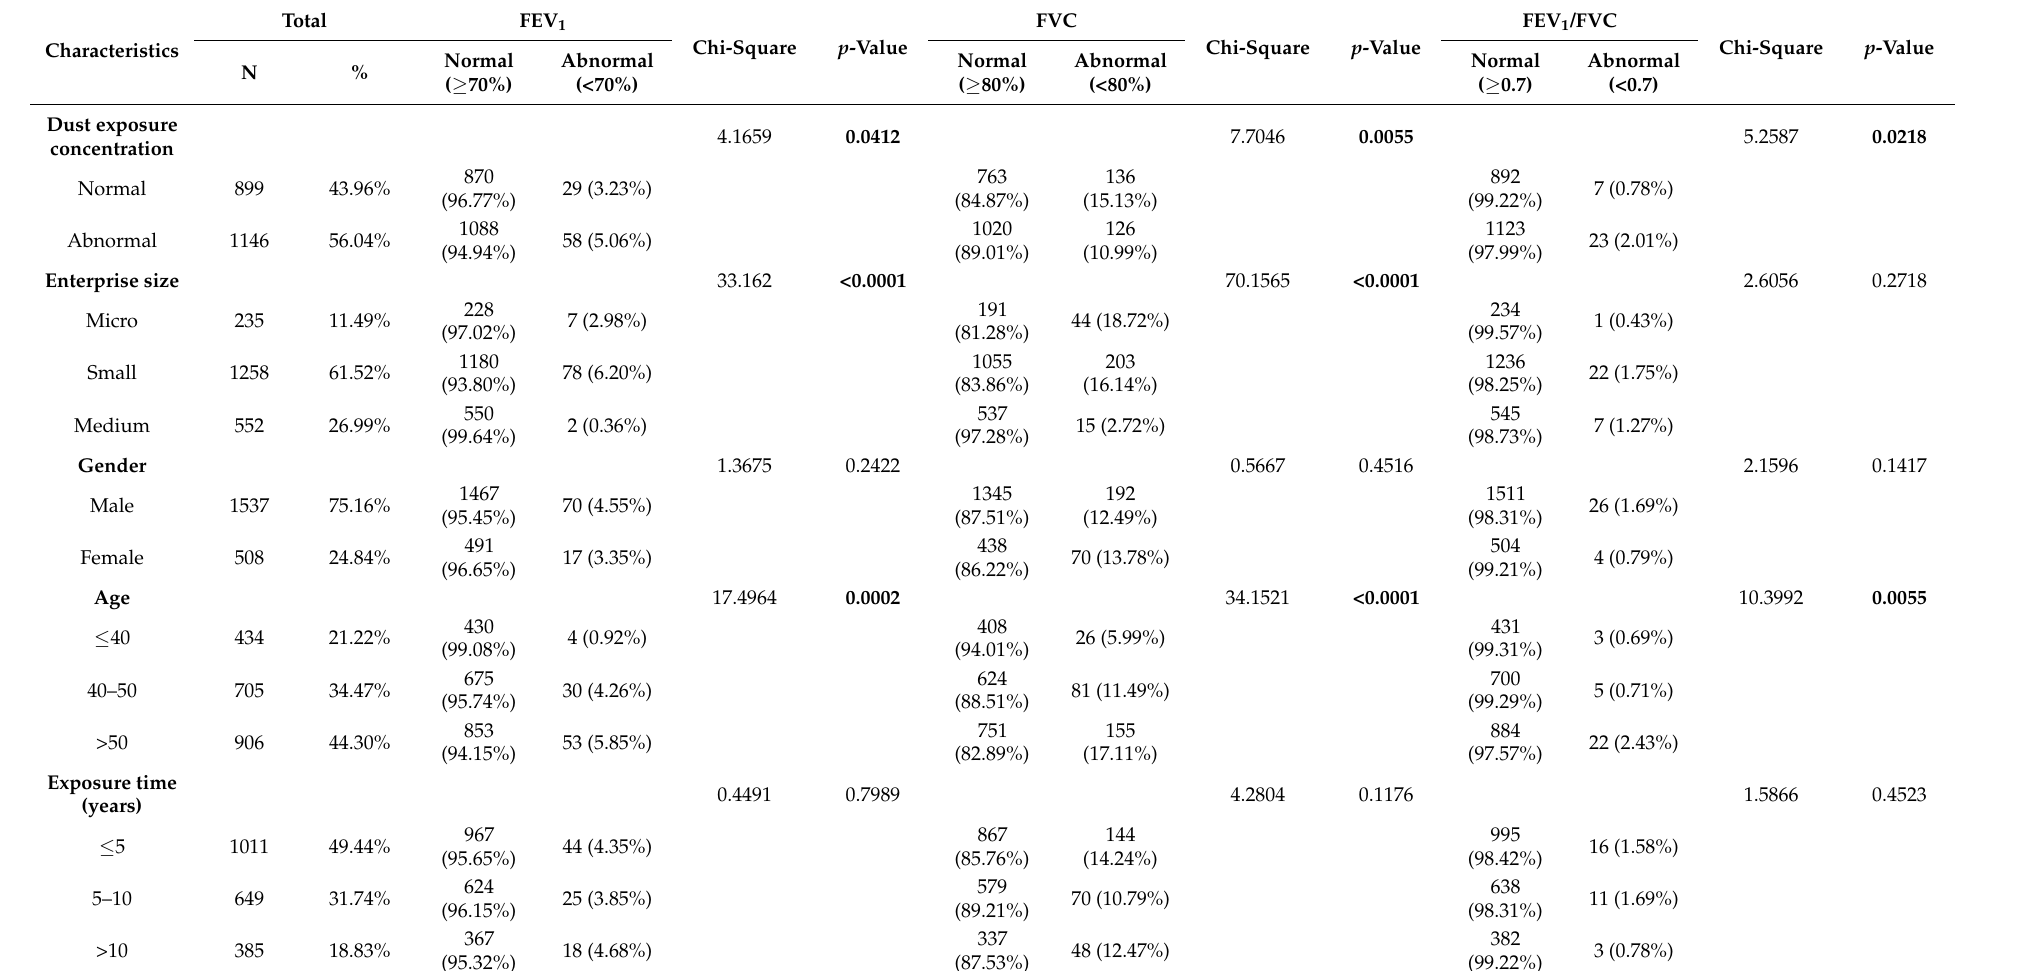
Table 2. Factors related to abnormal lung